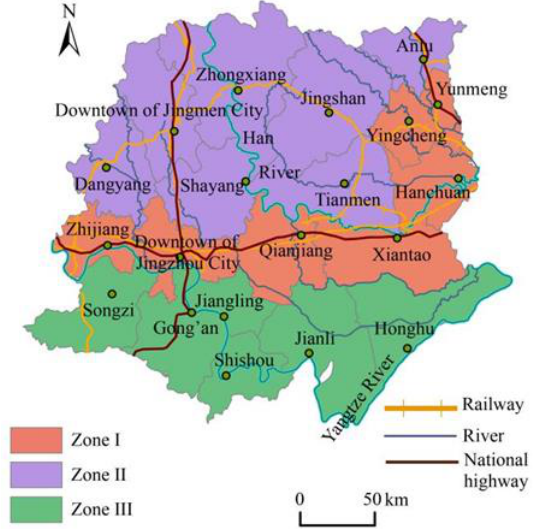
Figure 7. Zoning of rural revitalization development of Jianghan Plain.